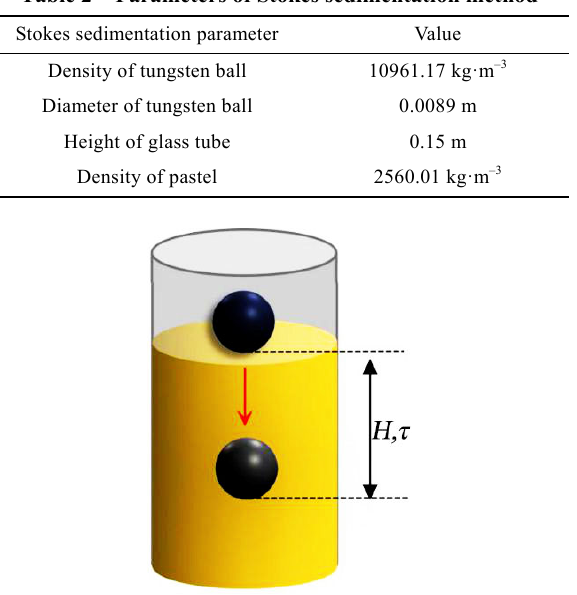
Fig. 2 Schematic diagram of the Stokes sedimentation method for viscosity